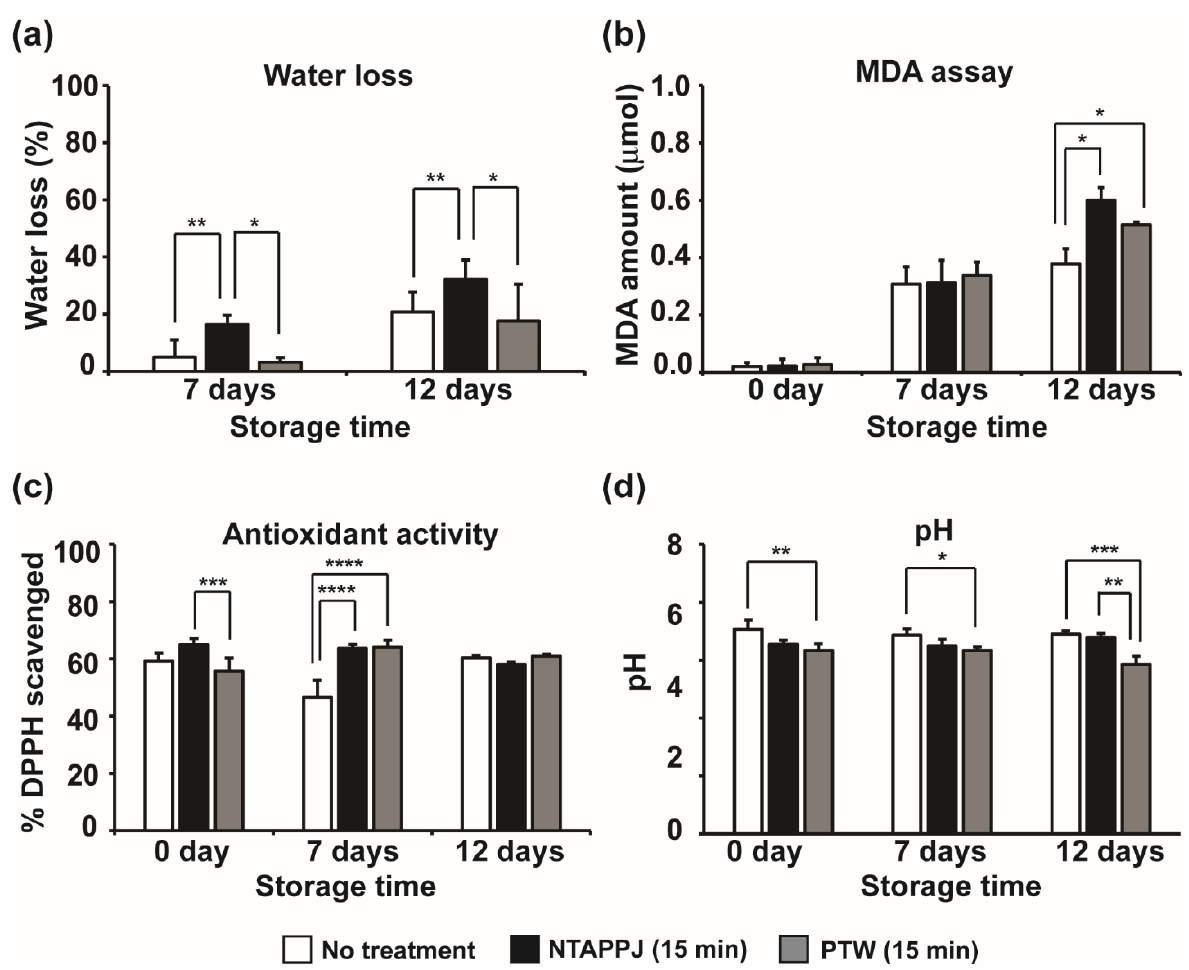
Figure 8. Measurement of water loss ( a ), lipid peroxidation ( b ), antioxidant activity ( c ), and pH ( d ) in mushroom after no treatment, NTAPPJ treatment, and PTW treatment. Values were the average of three to six measurements. Only significantly different groups were indicated; * p < 0.05, ** p < 0.01, *** p < 0.001, **** p < 0.0001.